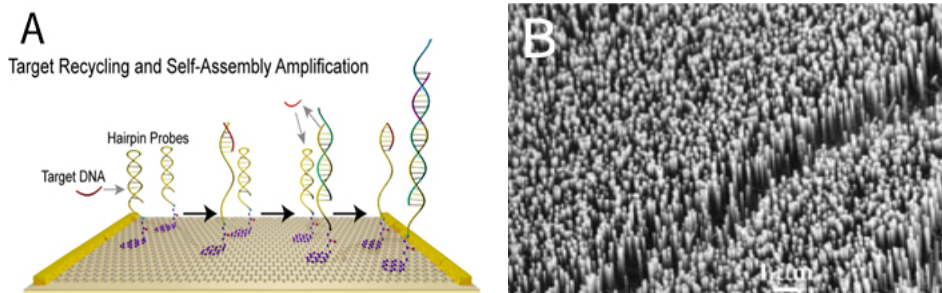
Figure 1. ( A ) Target recycling and self-assembly amplification. Reprinted with permission from ref. [65]. 2018 American Chemistry Society ( B ) The epitaxial growth of ZnO nanowires on the plane of a (110) sapphire substrate can be readily seen by examination of the crystal structures of ZnO and sapphire). Reprinted with permission from ref. [66]. 2002 Wiley-VCH.